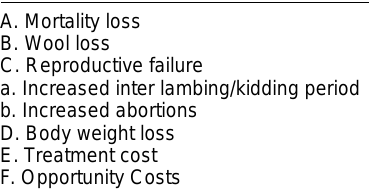
Table-1. Components of losses due to PPR in sheep and goats